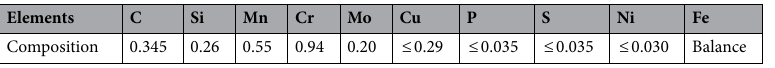
Table 1. Chemical composition of 35CrMo steel (wt%).